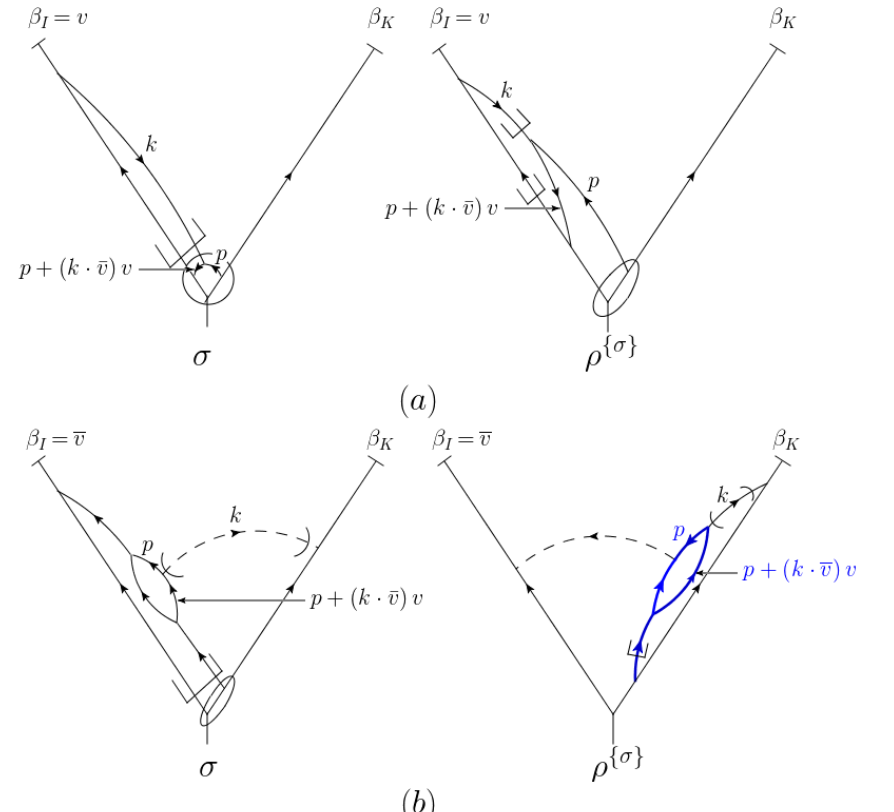
Figure 5. This (cid:12)gure illustrates the examples discussed in item (Bii): how a generic loop momen- tum p (cid:22) of (cid:12)gure 4 is pinched, as in eq. (2.16), to be collinear to a projection vector v (cid:22) of t (cid:27) , at the pinch surface (cid:26) f (cid:27) g of t (cid:27) A . For each of these diagrams, the jet subgraph J I ( J K ) consists of the solid lines connected to the external line marked (cid:12) I ( (cid:12) K ) in the (cid:12)gure, outside of the lines that are encircled. The encircled propagators are in the hard subgraph, and the dashed lines are soft. The propagators marked bold and blue are for later use (to identify certain subgraphs) in section 2.4. (a) The case where t (cid:27) applies a hard-collinear approximation for which v (cid:22) = (cid:12) (cid:22) . The pinch surface I (cid:27) of A is represented on the left, including the hard-collinear approximation, and the pinch surface (cid:26) f (cid:27) g of t (cid:27) A is shown on the right. (b) The case where t (cid:27) acts with a soft-collinear approximation (cid:22) for which v (cid:22) = (cid:12) . The pinch surface (cid:27) of A is represented on the left, including the soft-collinear I approximation, and the pinch surface (cid:26) f (cid:27) g of t (cid:27) A is shown on the right. In the case of a soft-collinear approximation, k (cid:22) is soft in (cid:27) , and p (cid:22) can be taken as a loop momentum in jet J ( (cid:27) ) with (cid:12) (cid:22) = v (cid:22) . In region (cid:26) f (cid:27) g , found as the pinch I I f (cid:27) g ) J ( (cid:26) K than the direction (cid:12) (cid:22) . An explicit three-loop example is shown in (cid:12)gure 5(b). K (Biii) p (cid:22) is collinear to another vector v 0 (cid:22) ( 6 = v (cid:22) ) in (cid:26) f (cid:27) g . Then by construction, the con- (cid:13)uence momentum p (cid:22) + ( k (cid:1) v ) v (cid:22) is hard, and both ( k (cid:1) v ) v (cid:22) and k (cid:22) correspond to the same con(cid:12)guration of (cid:12)gure 4, i.e. two jet lines of di(cid:11)erent directions joining the hard subgraph together.